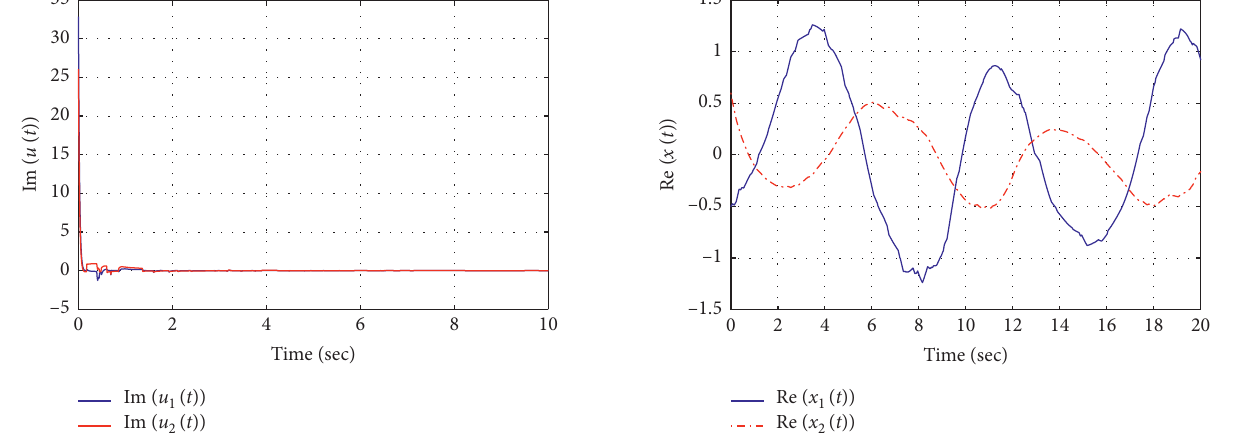
Figure 3: Responses input u ( t ) of the imaginary